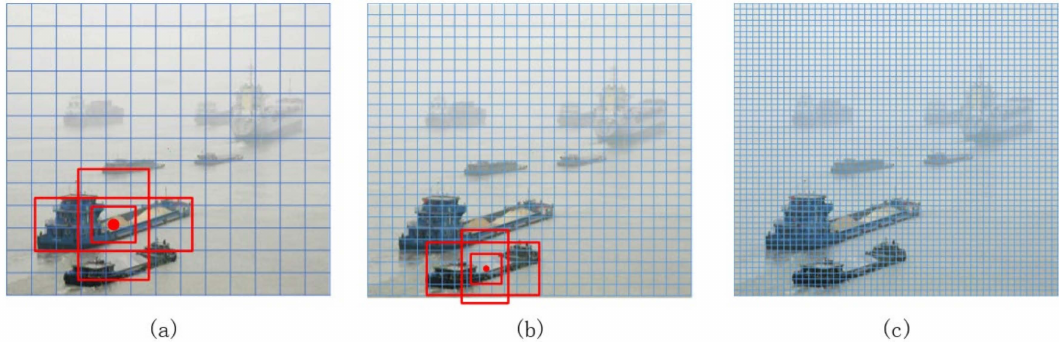
Figure 4. Output diagram of different sizes. ( a ) 13 × 13 grid cell. ( b ) 26 × 26 grid cell. ( c ) 52 × 52 grid